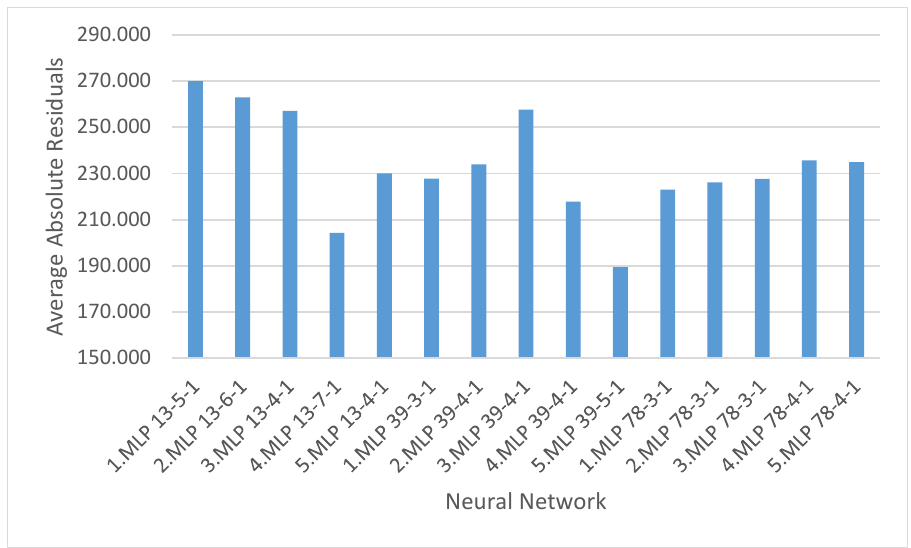
Figure 2. Comparing average absolute residuals of equalized time series of RF export to PRC (Source: Author).